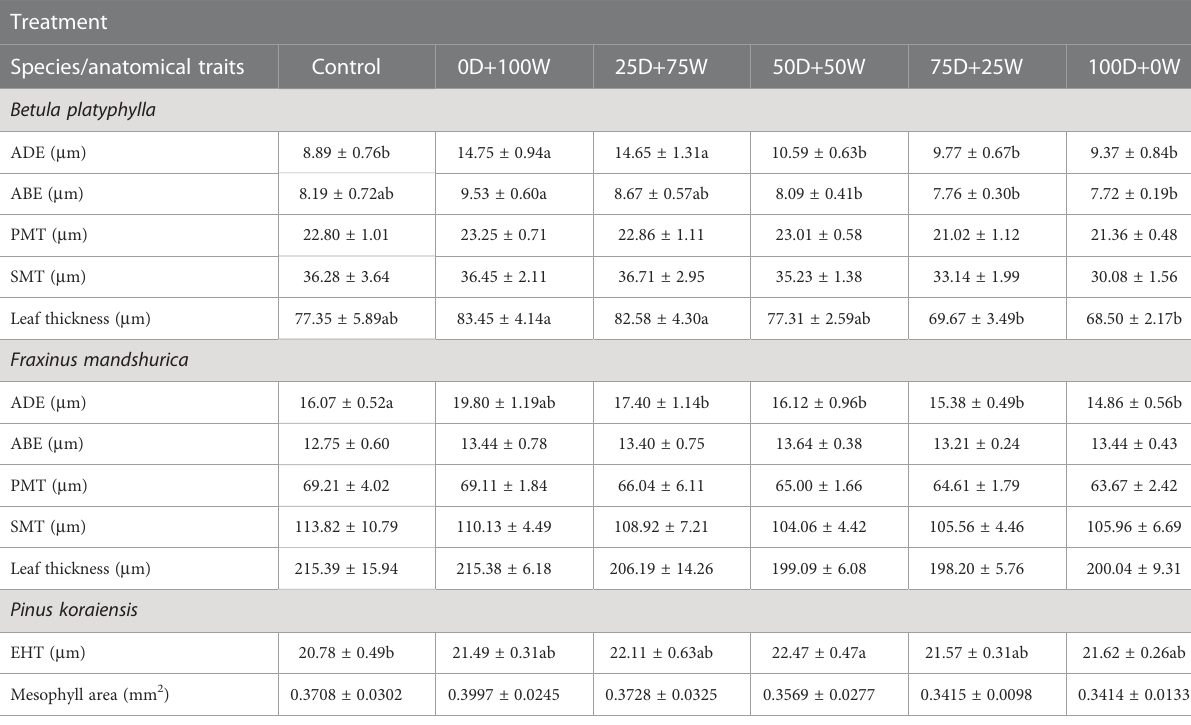
TABLE 2 Leaf anatomical traits of three species affected by six canopy nitrogen (N) application treatments for 32 days. Treatment Species/anatomical